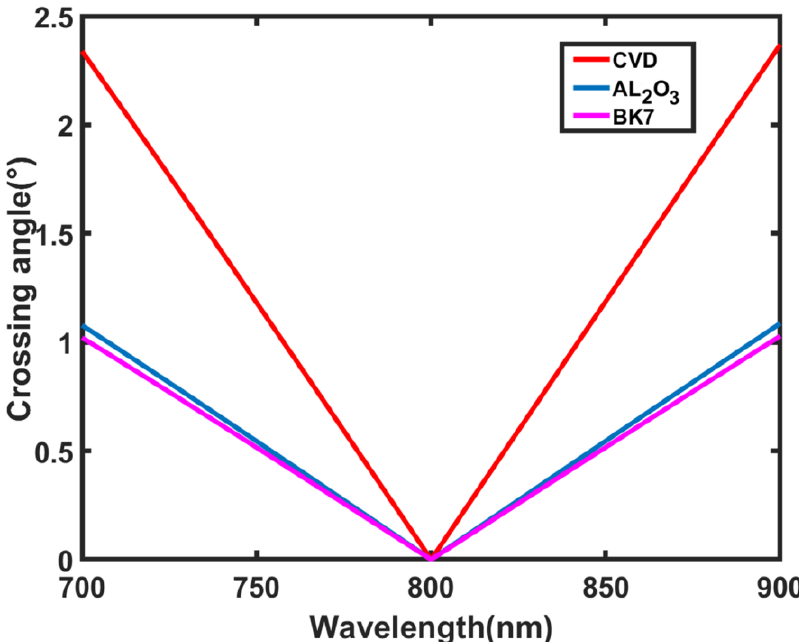
Figure 3. Suitable crossing angles of the three Kerr media, BK7 glass, Al 2 O 3 and CVD diamond, when one input beam’s wavelength is fixed at 800 nm.